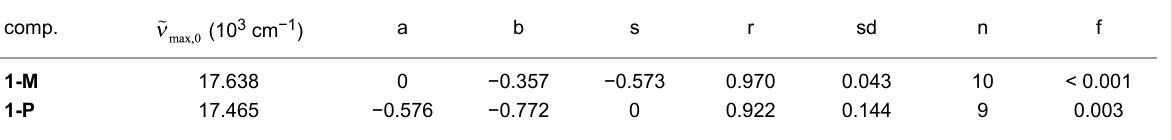
Table 5: Solvent-independent correlation coefficients a, b and s of the Kamlet–Taft parameters α , β and π * ; solute property of the reference system , correlation coefficient (r), standard deviation (sd), number of solvents (n) and significance (f) for the fluoro-solvatochromism of 1-M and 1-P . comp.